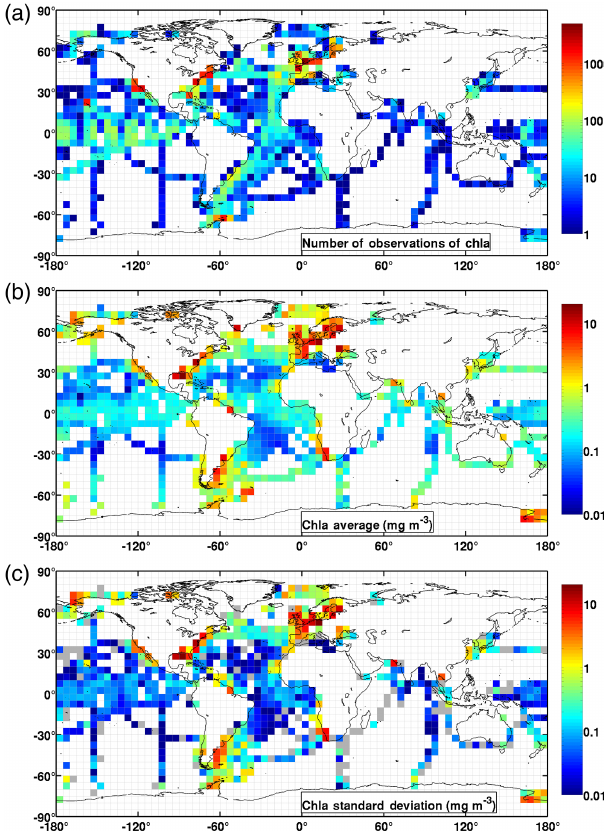
Figure 10. The chlorophyll a (mgm − 3 ) data partitioned into 5 ◦ × 5 ◦ boxes showing the (a) number of observations, (b) average value and (c) standard deviation in each box. All chlorophyll data were considered, but for a given station HPLC data were selected if available. In the standard deviation plot, grey represents boxes with zero standard deviation (i.e. one